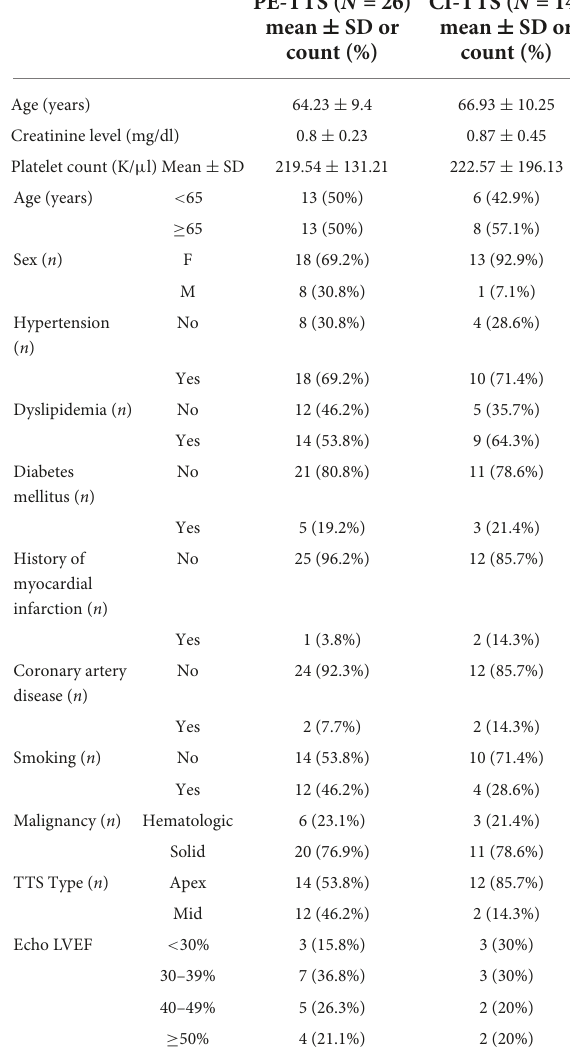
TABLE 1 Baseline characteristics of the studied population. TABLE 2 Demographic information for the study group organized by proposed TTS mechanism (PEM-TTS vs.